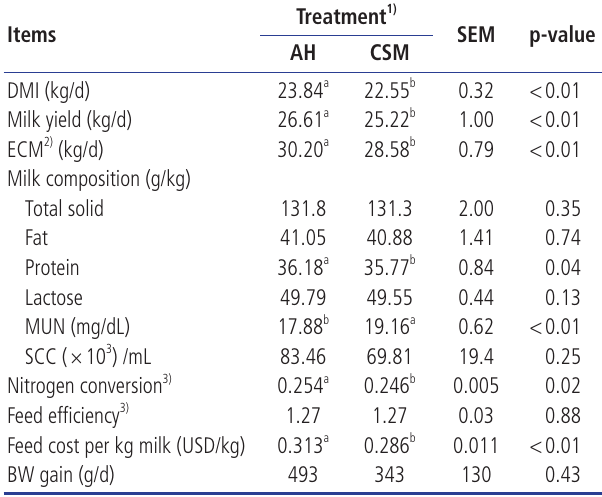
Table 2. Lactation performance in dairy cows fed experimental diets